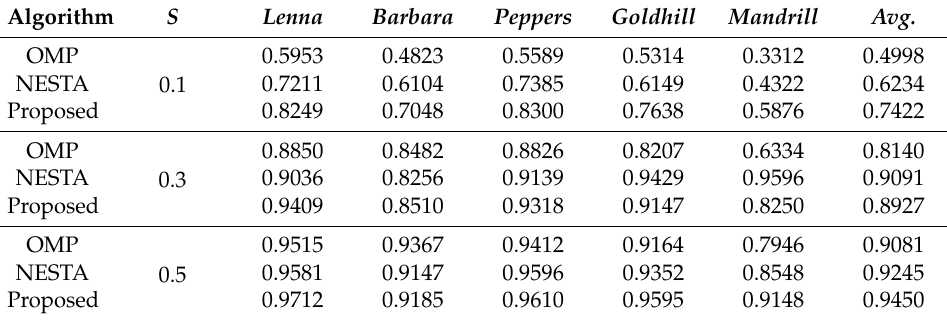
Table 3. Structural SIMilarity (SSIM) comparison of different recovery